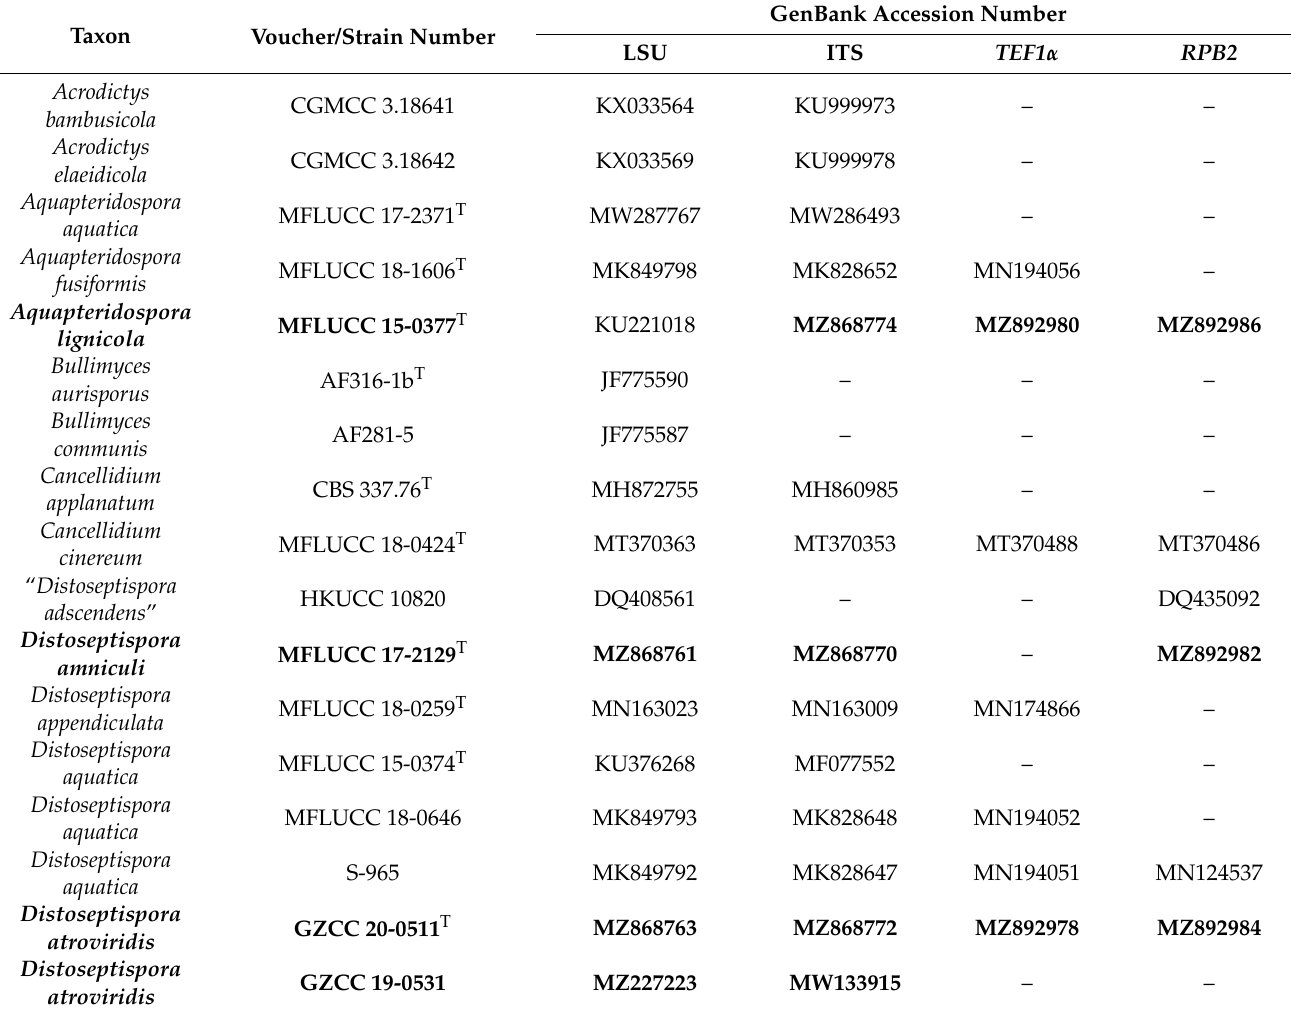
Table 1. Taxa used in the phylogenetic analyses and their GenBank accession numbers. T denotes ex-type strains. Newly generated sequences are in